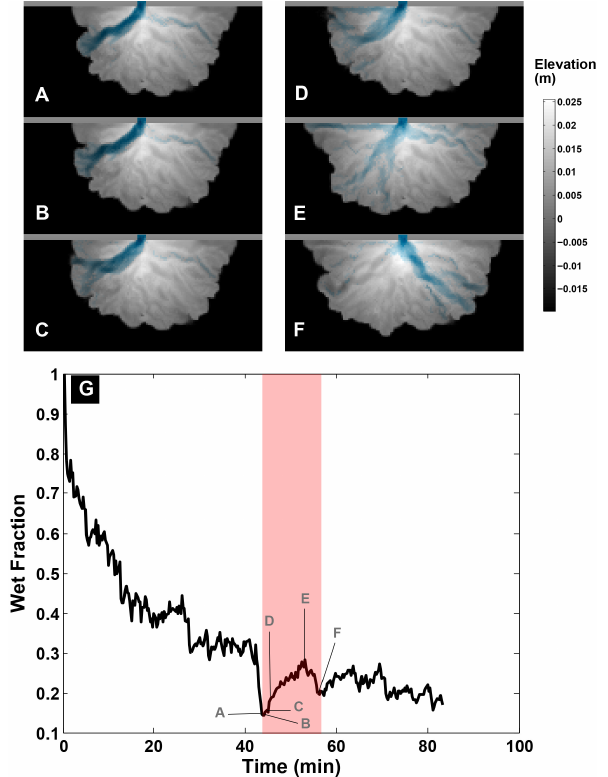
Figure 8. The series of images matches the avulsion cycles observed in physical experiments (Reitz and Jerolmack, 2012): (a) channelizes, (b) pushes out the shoreline (only deposits at the channel mouth), (c) flares out locally to establish a semicircular lobe (deposits minilobes around original channel mouth by local avulsions and sheet flow), (d) backfills (channel widens), (e) floods, and (f) channelizes again. Note that the time interval between (d) and (e) is about 4 times longer than any other pair of consecutive frames.